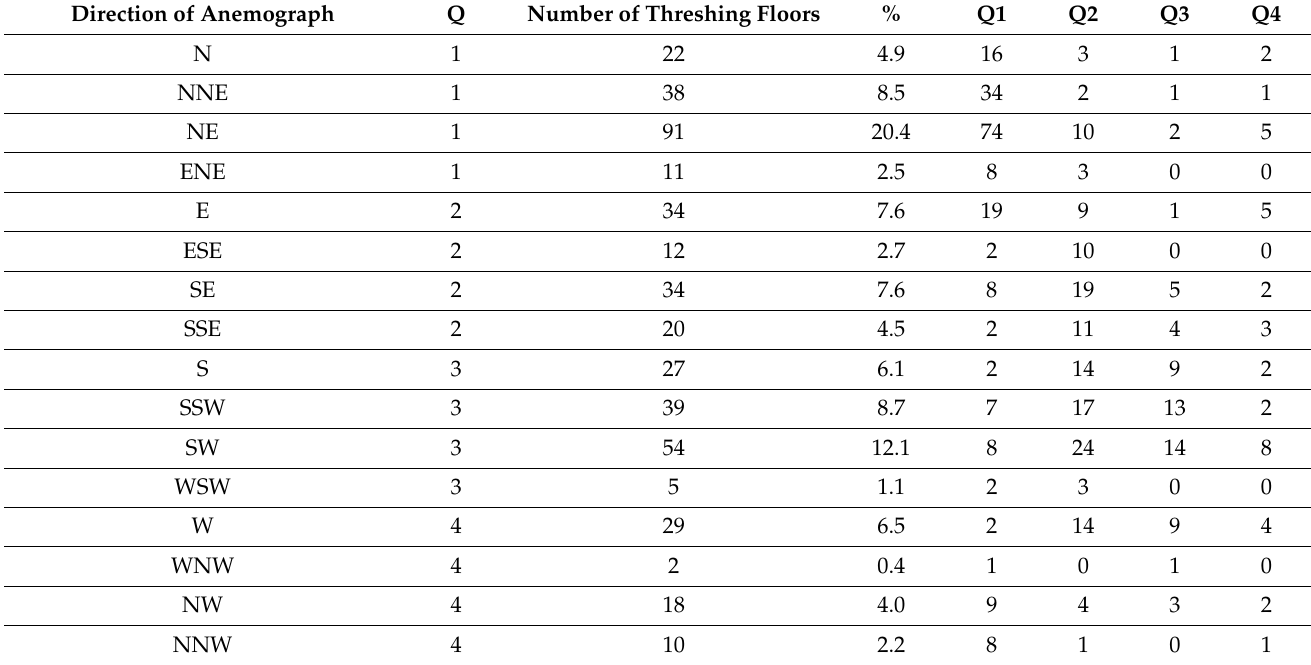
Table 1. Frequencies of the anemographs (wind-direction) of the threshing floors. The second column (Q) indicates wind quadrant assigned to each direction. The four last columns indicate the absolute number of threshing floors located in each of the four quadrants (Q1, Q2, Q3 and